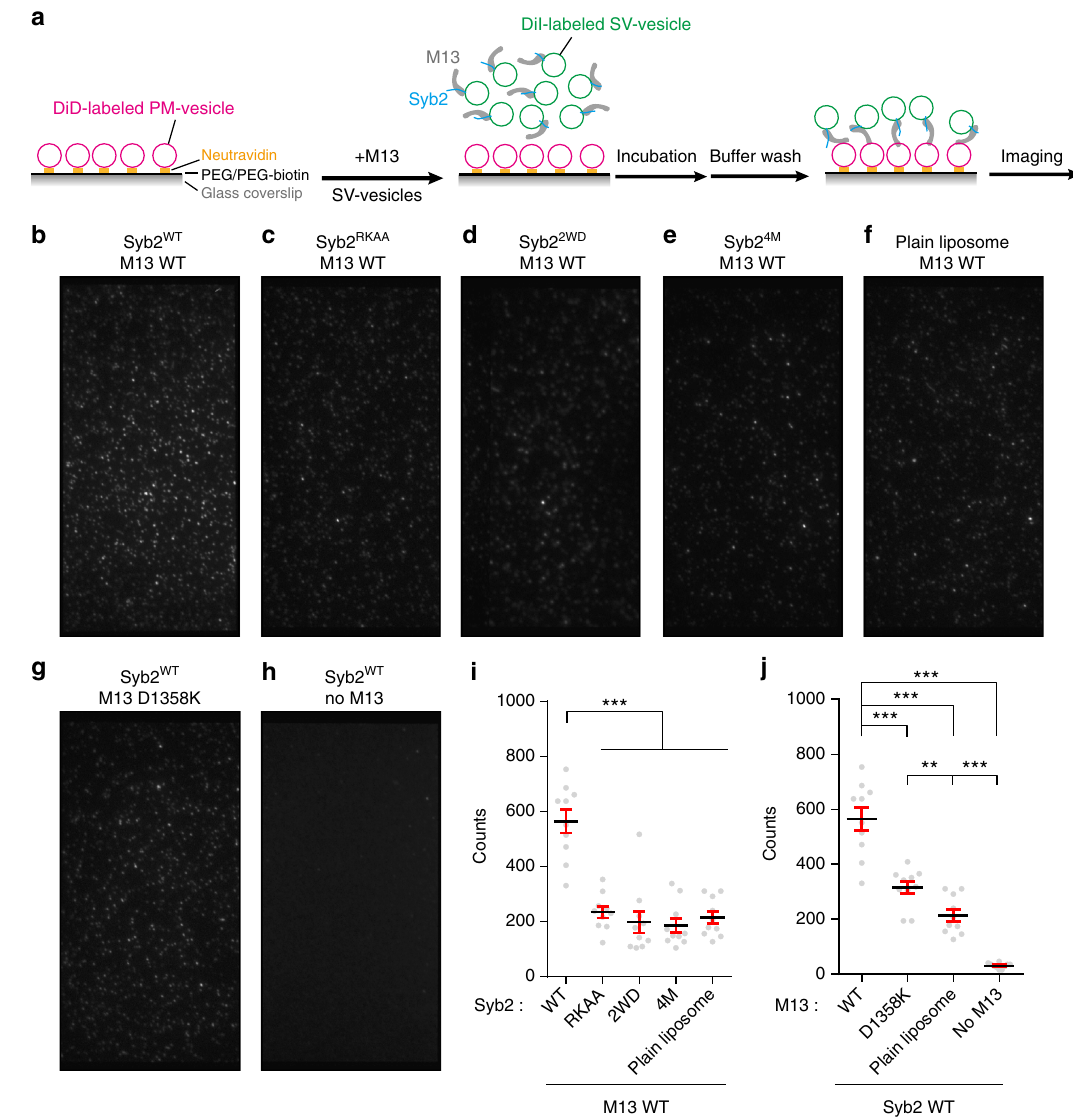
Fig. 7 Syb2/MUN interaction promotes membrane association. a Illustration of the single-vesicle tethering assay. Glass surfaces were modi fi ed by PEG and biotin-PEG mixtures. DiD-labeled PM-vesicles containing 0.5% biotin-PE were fi rst immobilized on a surface treated with neutravidin. After extensive washing, 1 μ M Munc13-1 C 1 -C 2 B-MUN fragment (M13) and 40 μ M (total lipids) Dil-labeled SV-vesicles were added and incubated for 30 min at 30